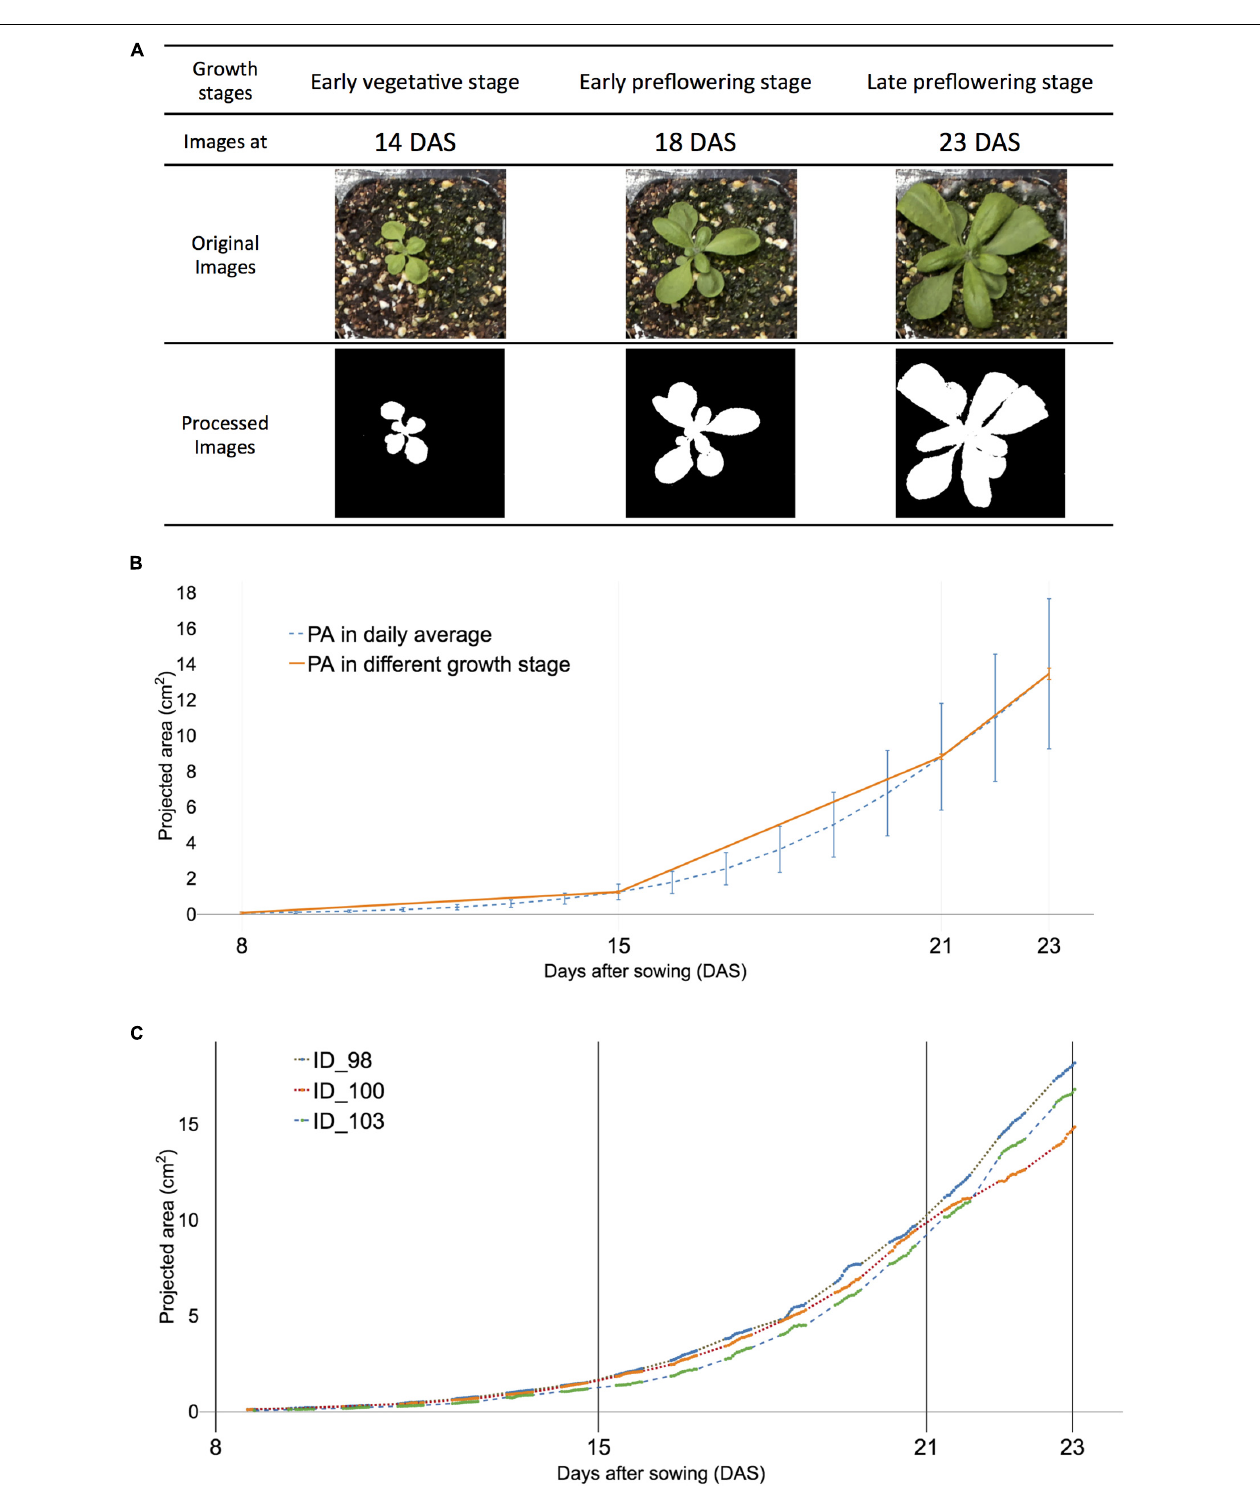
FIGURE 2 | Definition of early vegetative, early, and late pre-flowering stages were used in the study to visualize corresponding projected area (PA) of all and selected samples of Arabidopsis . (A) Visualized plant images at three growth stages: early vegetative [8–15 days after sowing (DAS)], early pre-flowering stage (15–21 DAS), and late pre-flowering stage (21–23 DAS). (B) The visualized growth pattern of all samples. Dashed blue lines indicate the average PA in each DAS. The orange solid line indicates PA at early vegetative, early, and late pre-flowering stages, respectively. (C) The visualized growth pattern of selected individual Arabidopsis samples of ID 98 (dot), ID 100 (dash with lines), and ID103 (dash). The actual measurement time point is displayed with solid lines in each sample.